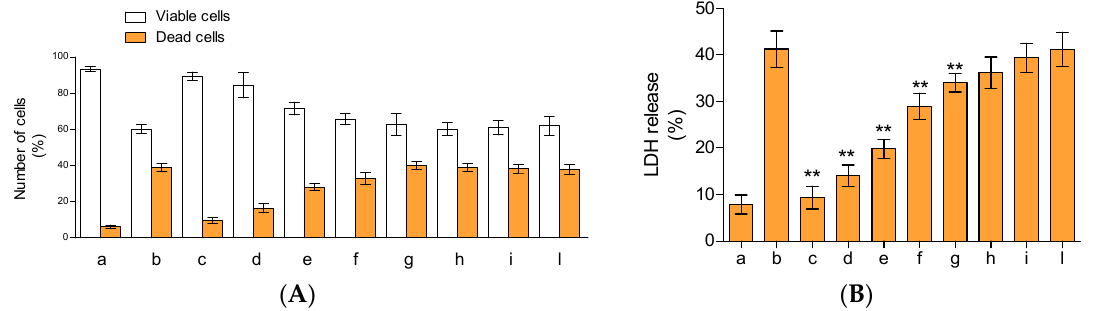
Figure 4. Cytoprotective effects of HEO on tert-butyl hydroperoxide ( t -BOOH) treated lymphocytes. Lymphocytes plus 100 μ M of t -BOOH were incubated for 24 h in the absence (b) or in the presence of 20, 17.5, 15, 12.5, 10, 7.5, 5, or 1 μ g/mL of essential oil (c–l, respectively). Lymphocytes incubated under the same experimental condition without t -BOOH (a). Cell vitality and integrity were analysed by trypan blue staining ( A ) and lactate dehydrogenase (LDH) release ( B ). The asterisks (**) indicate significant differences ( p < 0.05). Each value represents mean ± SD ( n = 3).